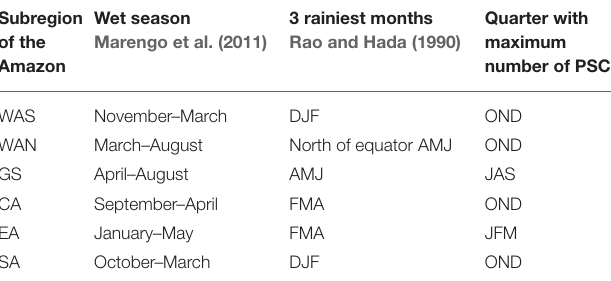
TABLE 4 | Beginning and end of the wet season from Marengo et al. (2011) , rainiest quarter from Rao and Hada (1990), and the quarter with maximum number of occurrences of